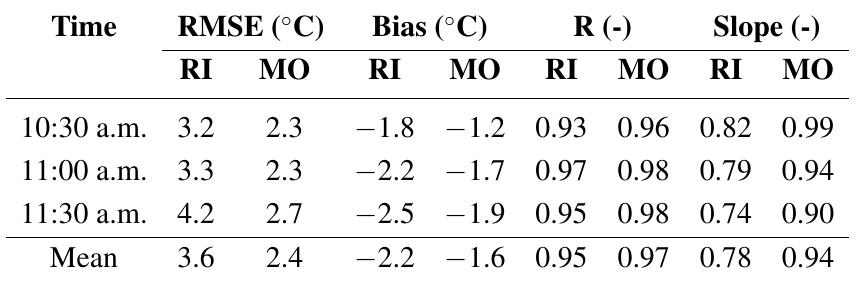
Table 1. Root mean square error (RMSE), bias, correlation coefficient (R) and slope of the linear regression between soil Tends simulated by the energy balance model for bare soils (EBsoil) with the RI and MO aerodynamic resistance and the soil Tends observed in situ at the soil plots of the R3 perimeter.